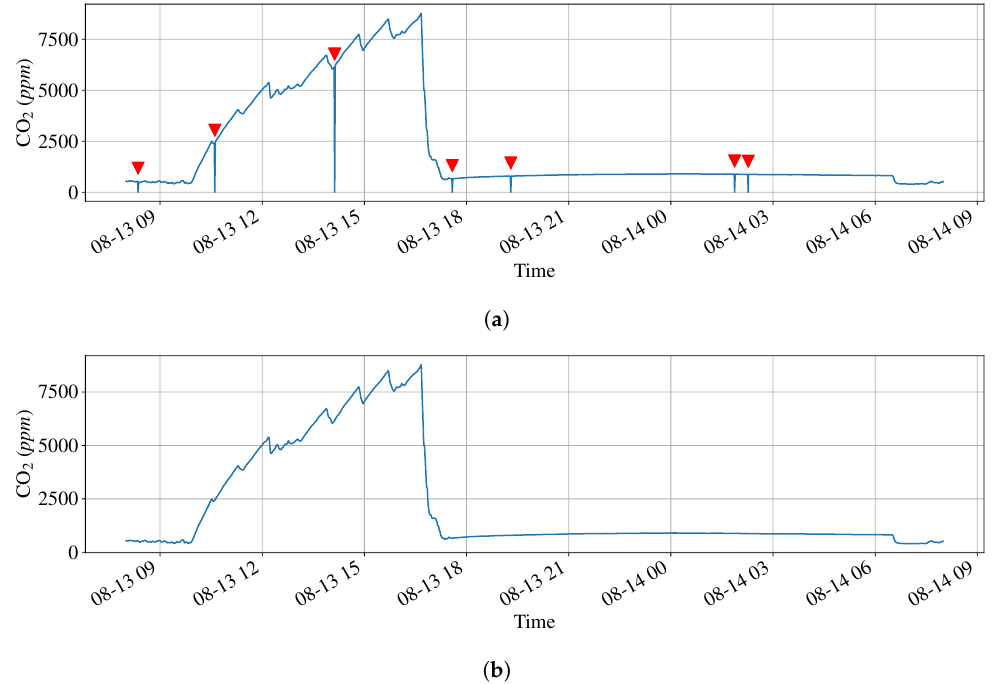
Figure 4. Data preprocessing on CO 2 concentration. ( a ) Raw data collected from air box. ( b ) Remove sensing error